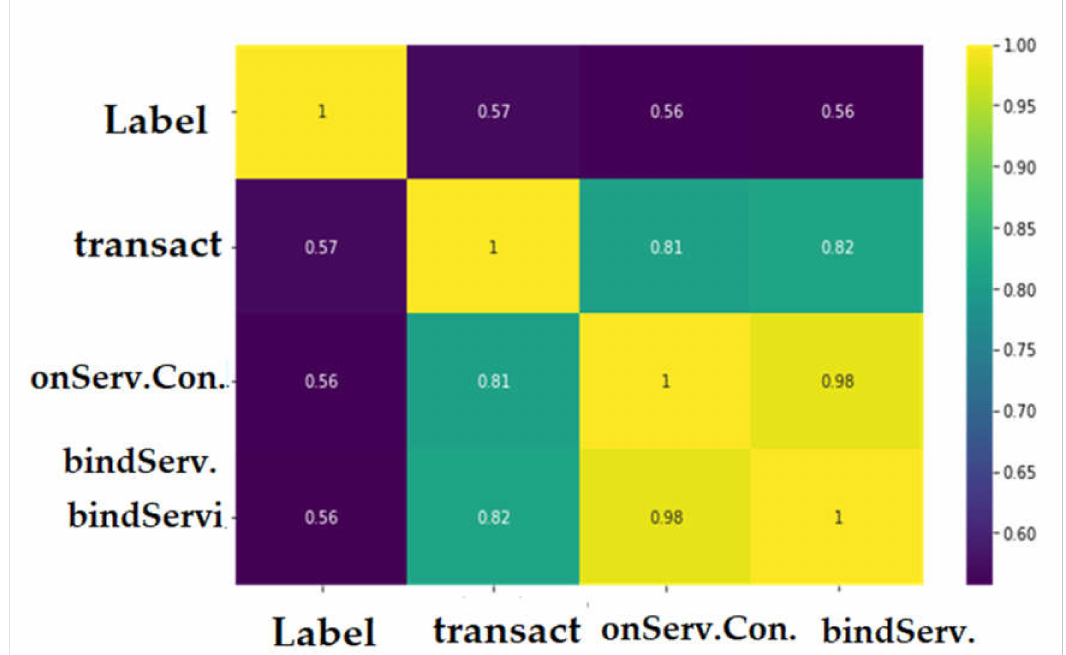
Figure 20. The correlation coefficient for the Drebin